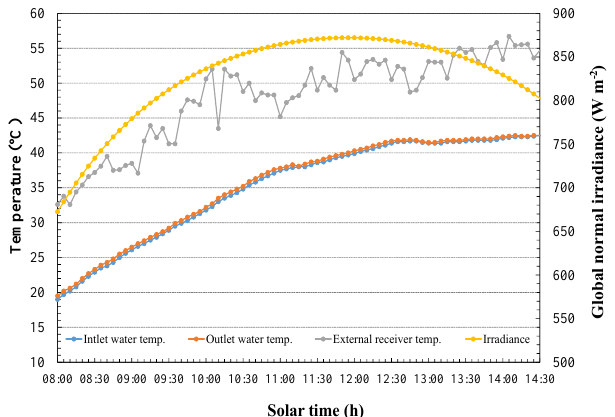
Figure 23. Temperatures recorded on 10 August and 28